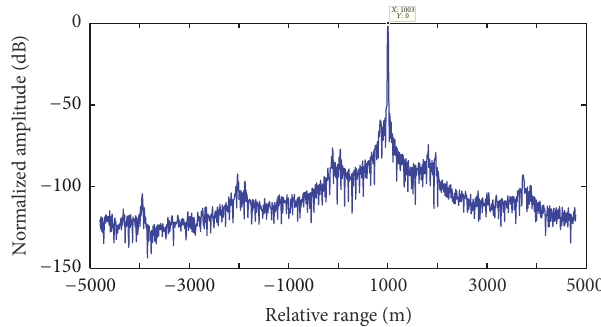
Figure 7: The jamming suppression result using 𝐻 𝑎 (𝑓) ( 𝑇 𝑠 = 2 𝜇 s).